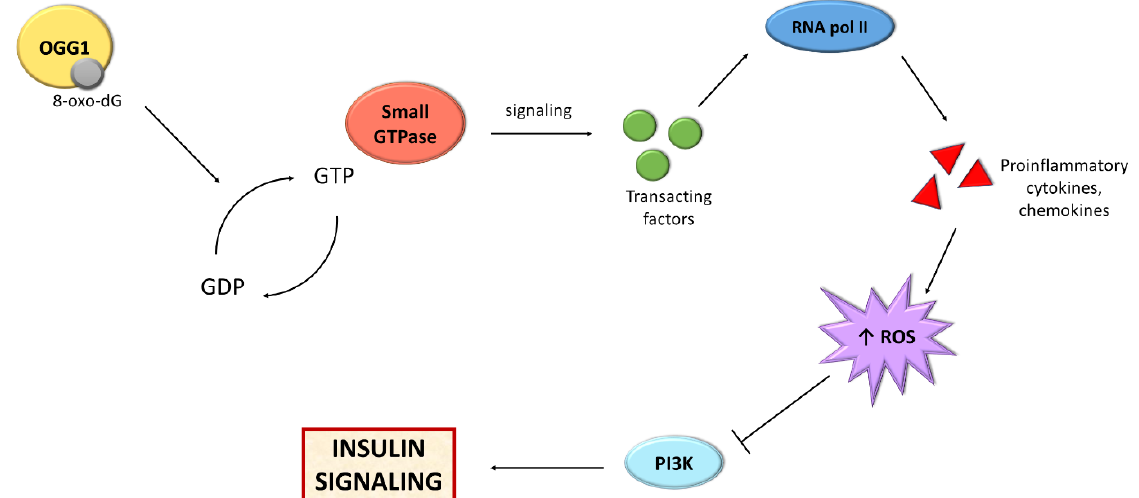
Figure 3. Scheme presenting the relationship between BER and insulin signaling. Abbreviations: GDP: guanosine diphosphate; GTP: guanosine triphosphate; OGG1: oxoguanine glycosylase; PI3K: phosphoinositide 3-kinase; RNA pol II: RNA polymerase II; ROS; reactive oxygen species.